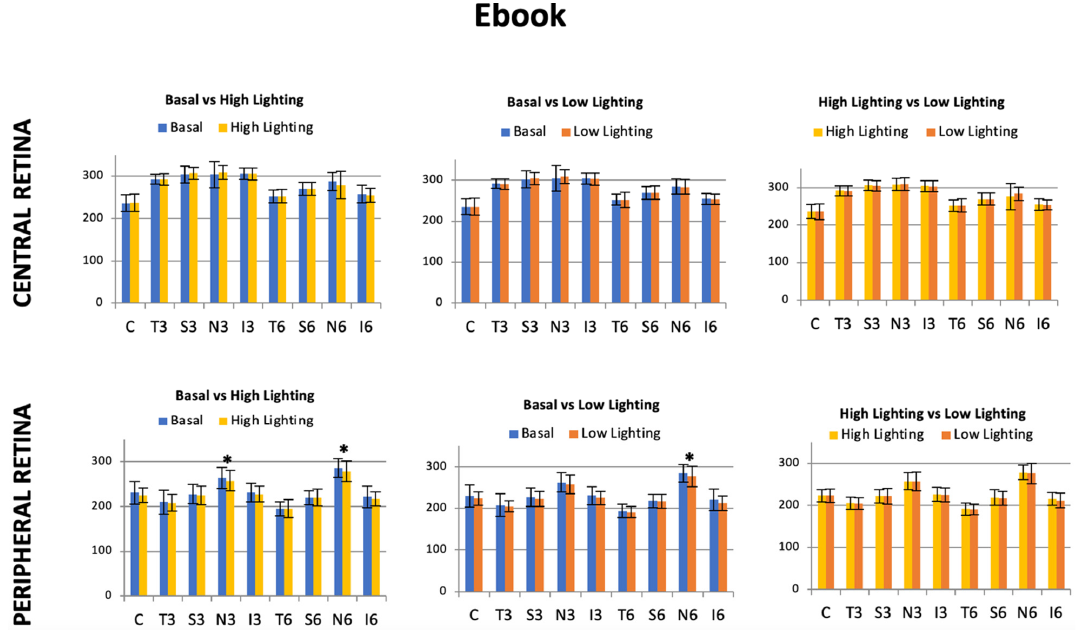
Figure 5. Mean and standard deviation (SD) of the central and peripheral retinal thicknesses (µm) in high and low lighting conditions in the nine ETDRS areas measured by 3D OCT-1000 after reading with an Ebook device. Differences that reached statistical significance ( p < 0.05) are marked with *. Regarding the total retinal volume, including the nine areas together, statistically sig- nificant differences were found only in the peripheral retinal volume between the basal thickness measurement and after reading with iPad in low light conditions (6.52 ± 0.52 mm 3 basal volume vs. 6.32 ± 0.44 mm 3 low lighting volume; p = 0.008), with less volume after reading, and between the peripheral retinal volume and iPad reading between light- ing conditions (6.40 ± 0.41 mm 3 high lighting volume vs. 6.32 ± 0.44 mm 3 low lighting volume; p = 0.023) (Figure 6), being lower in low lighting conditions.